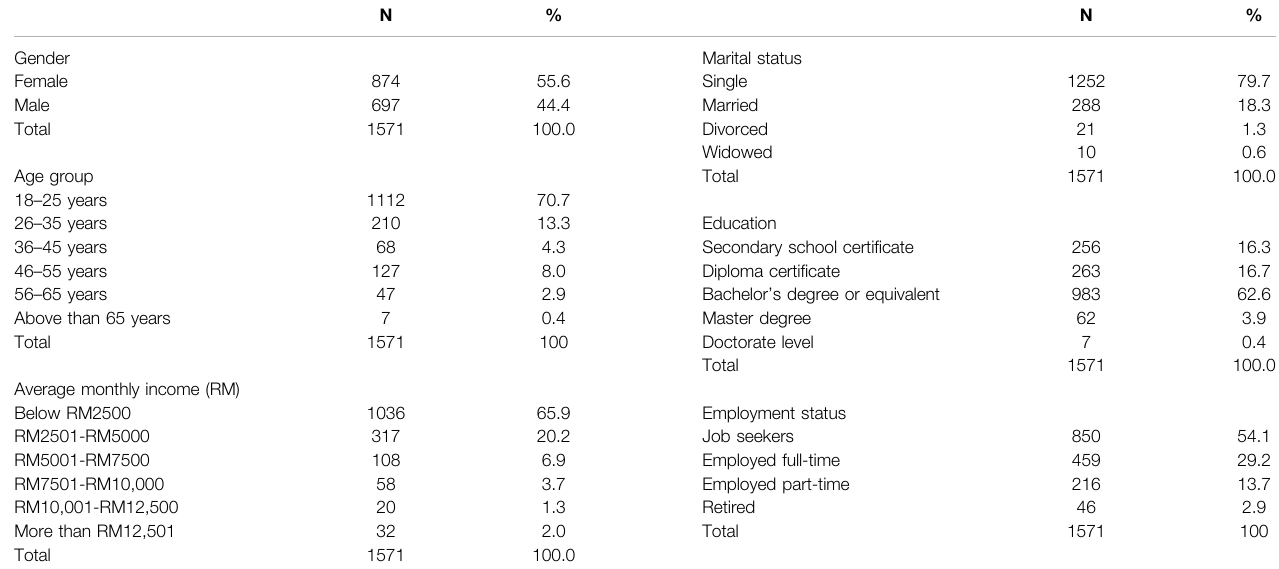
TABLE 1 | Respondent pro fi